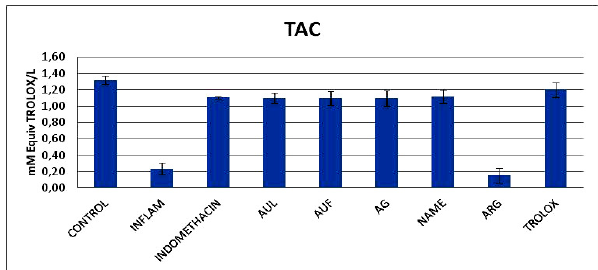
Fig. 2. Serum total antioxidant response Calculation of oxidative stress index